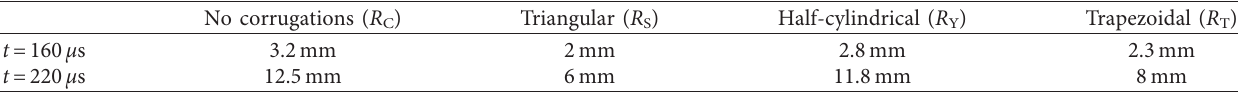
Figure 4: Diffraction process of the explosion shock wave on the vertical corrugated steel plate with (a) no corrugations ( R ( R S ), (c) half-cylindrical ( R Y ), and (d) trapezoidal ( R T ) corrugations. Table 1: Distance between diffraction wave and corrugated